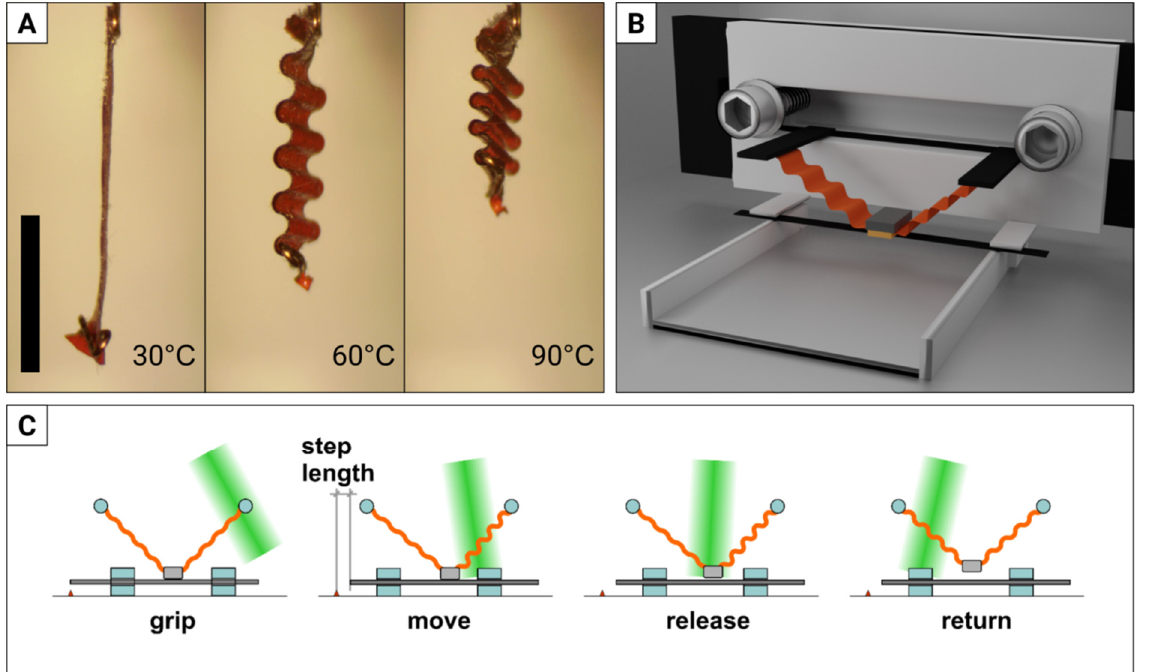
Figure 3. Light-powered linear inchworm motor. ( A ) Accordion-like actuator heated in an oven exhibits very large contraction, with up to 80% stroke. ( B ) CAD rendering of a linear stepping motor with two actuators (orange), gripper (dark grey/yellow) and a sliding shaft (black, under the gripper). ( C ) The sequential action of the actuators, powered by a scanned green laser beam, results in orbital motion of the gripper that, in turn, moves the shaft. The black scale bar in ( A ) is 5 mm long. Adapted from [52].